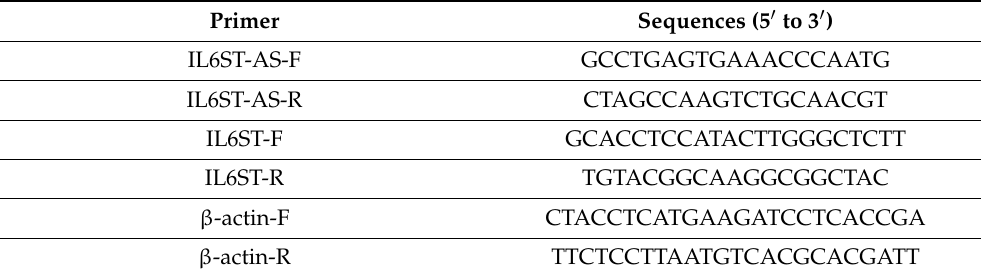
Table 1. The primer sequences of IL6ST-AS and